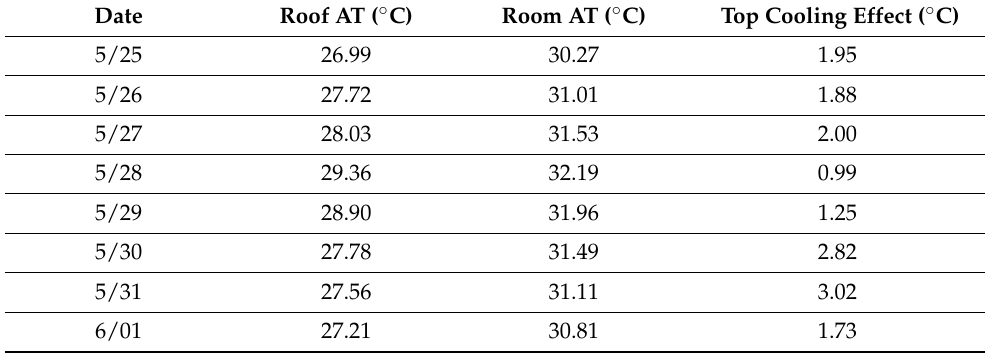
Table 6. Ambient temperatures of the ecological terrace during 04:00–05:00. Table 7. Ambient temperatures of the ecological terrace during 12:00–13:00.